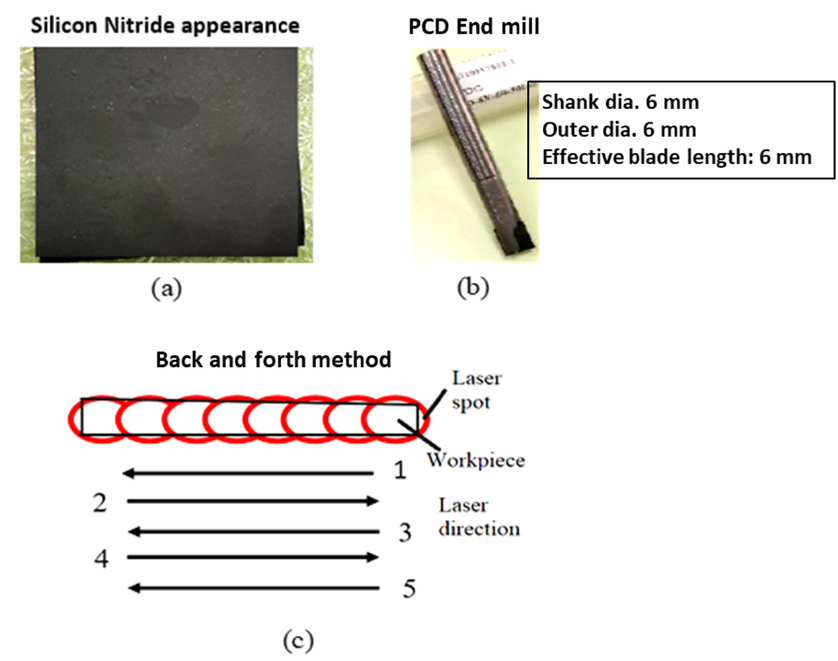
Figure 1. ( a ) Silicon nitride appearance, ( b ) PCD milling cutter, and ( c ) schematic illustration of the back-and-forth method.